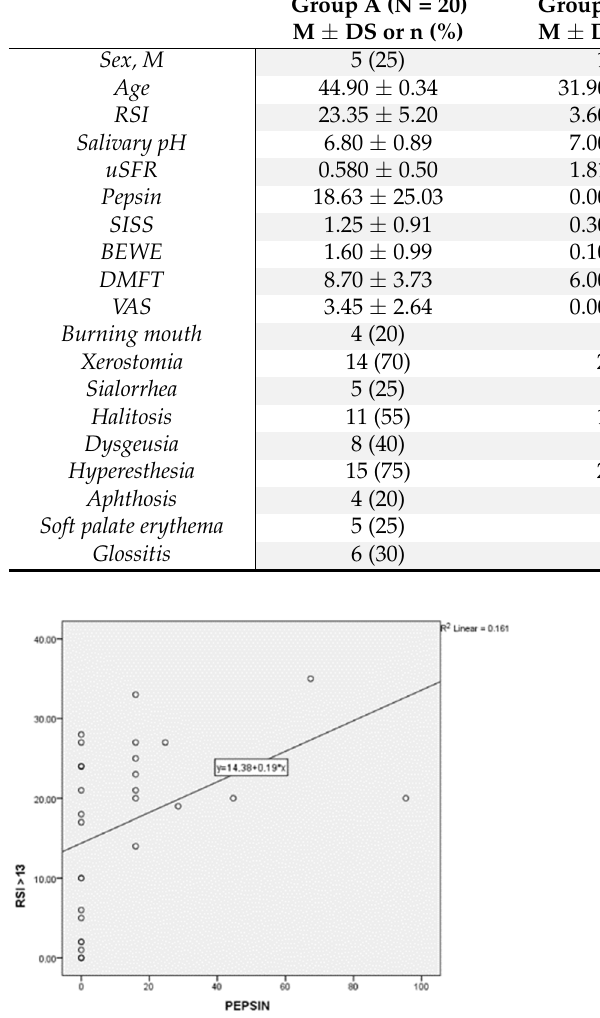
Figure 2. Oral pepsin levels correlated linearly with RSI scores ( p = Figure 3. Oral pepsin levels correlated linearly with RSI scores ( p = 0.028).